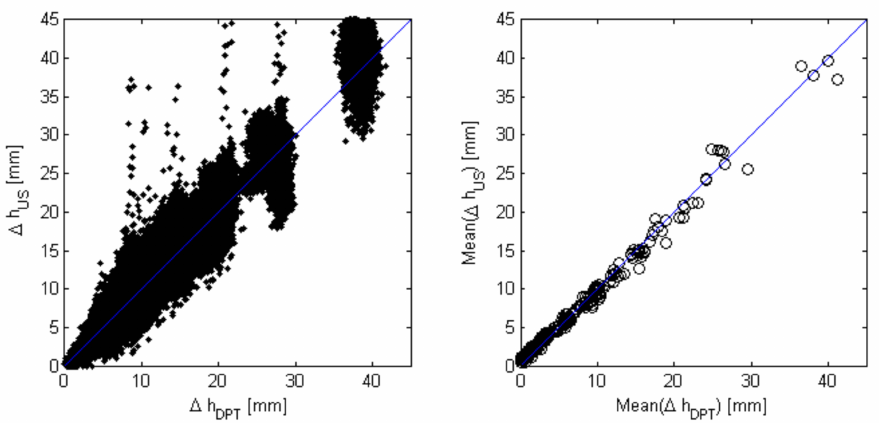
Figure 4. Comparison of pressure head loss ∆ h US and ∆ h DPT including all measuring points ( left ); and as a mean value for each geometrical set-up ( right